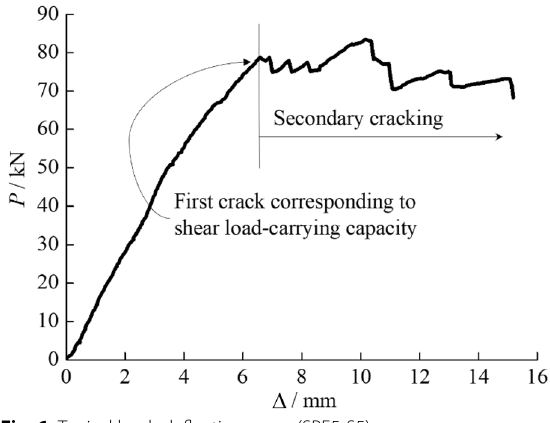
Fig. 6 Typical load–deflection curve